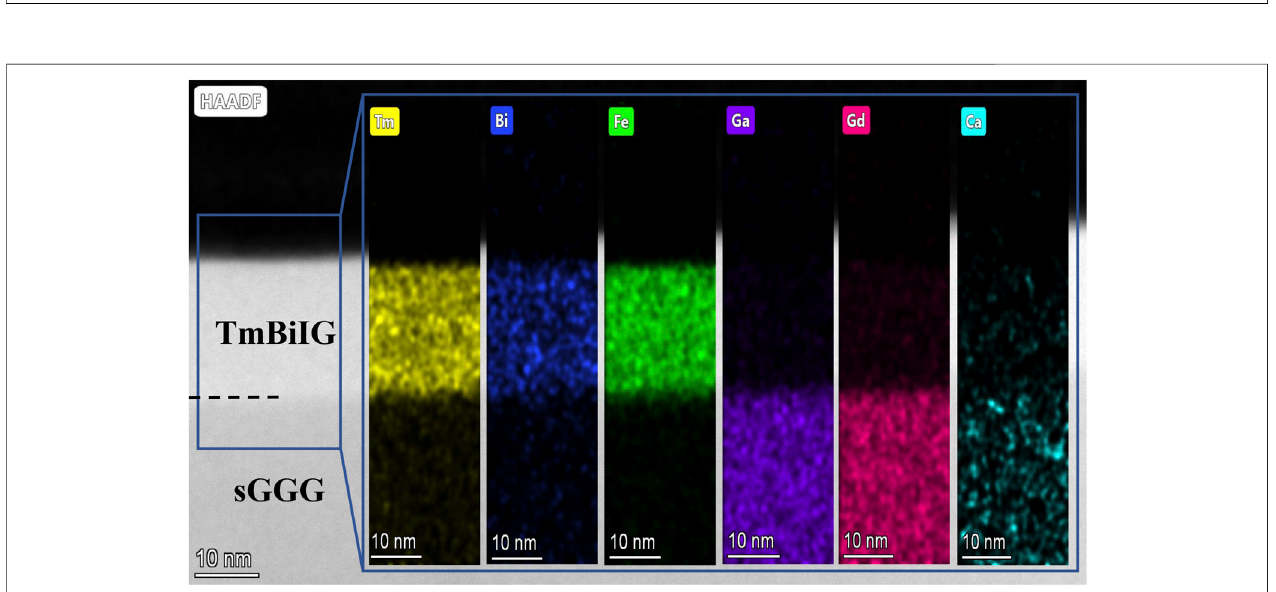
FIGURE 2 | HAADF-STEM image of the 20-nm-thick TmBiIG/sGGG cross-sectional structure. The black line of dashes shows the boundary between fi lm and substrate. EDS exhibits the location distribution of the Tm, Bi, Fe, Ga, Gd, and Ca elements by comparing different colors.